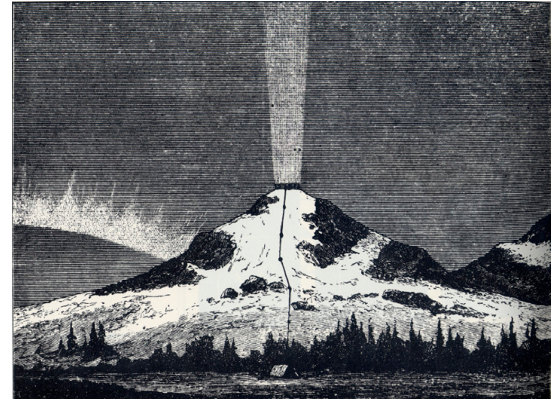
Figure 13. Apparatus erected by Selim Lemström at the top of Mount Oratunturi close to Sodankyla.